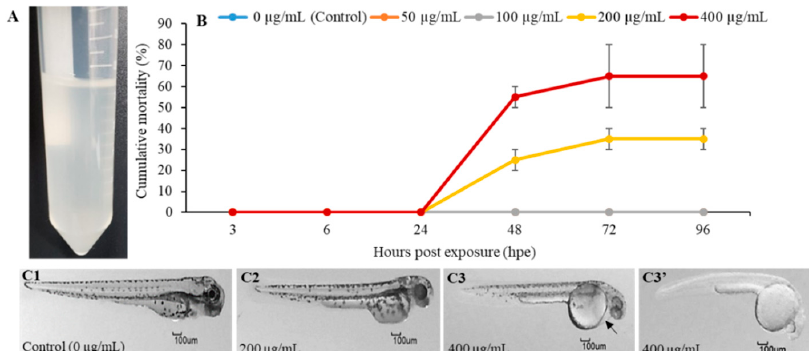
Figure 1. Solubility and effect of purified porcine gastric mucin (PGM) on the zebrafish embryos’ toxicity. ( A ) Type III PGM stock solution (4 mg/mL). ( B ) Mortality of zebrafish embryos exposed to